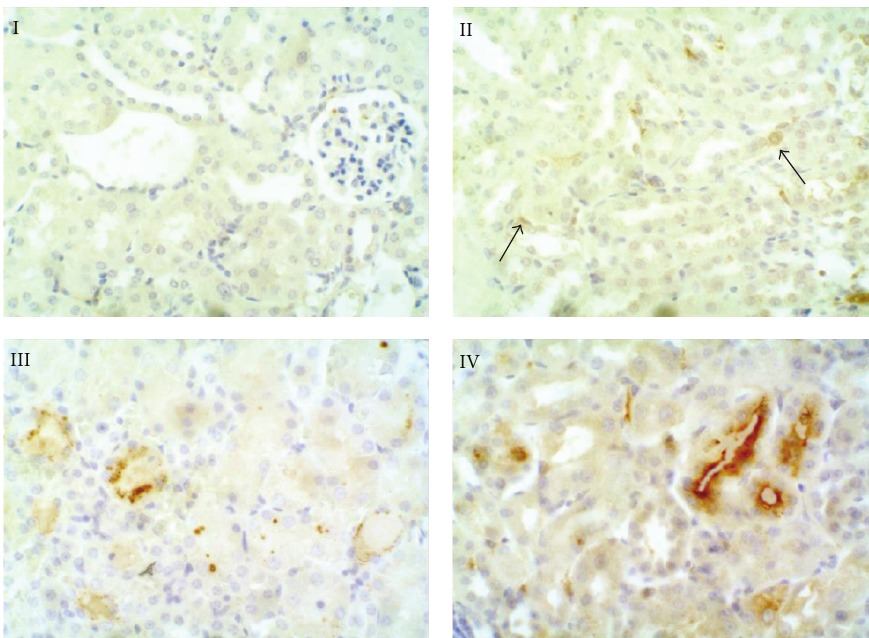
Figure 6: VEGF-A immunohistochemistry. I: control kidney. VEGF-A was not detected in the kidney of control mice. II: diabetic mice. Some of proximal tubules cells showed positive reaction to VEGF-A in the cytoplasm (right arrow). Endothelial cells were also immunostained (left arrow). III: LPS-treated mice. In some cells of convoluted tubules, VEGF-A was located in the cytoplasm with a granular pattern; in the other tubules, VEGF-A antibody showed a diffuse labelling. IV: diabetic LPS-treated mice. The highest reaction to VEGF-A was encountered in the kidney of diabetic mice treated with endotoxin. Magnification × 300.